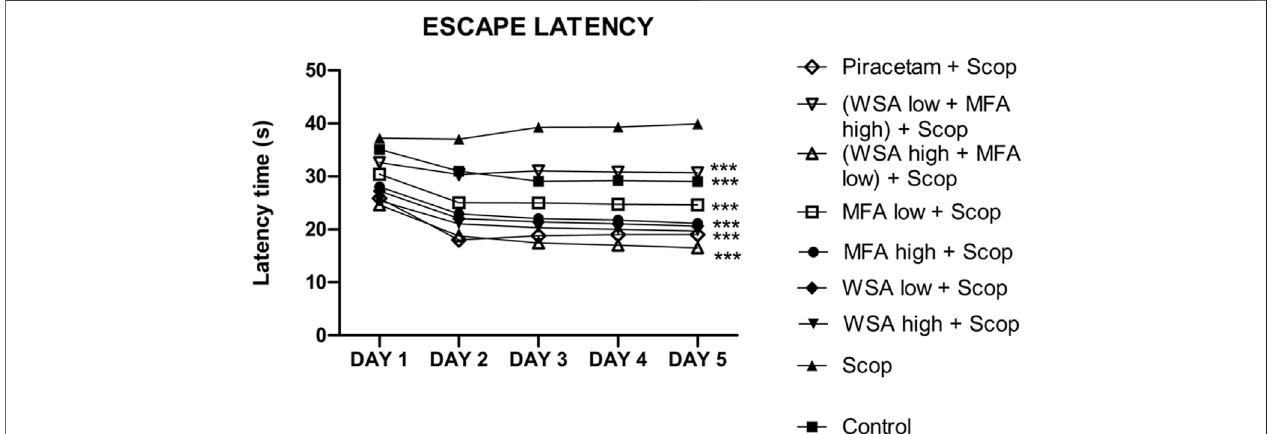
FIGURE 5 | Dynamics of escape latency in the spatial acquisition trial in reference memory test in male wistar rats in Morris water maze. There were fi ve days acquisition trials with 30 s inter-trial intervals and each data point is the mean of four trials. The data is represented as Mean ± SEM. Each line in the plot shows the average of six mice in each group. Markers represent the differences *** p < 0.001 when compared to Scop group; analyzed by one-way ANOVA followed by Dunnett ’ s Multiple Comparison Test.